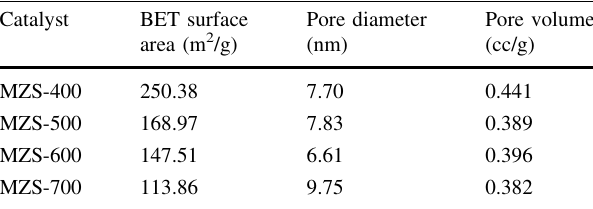
Table 1 Physical properties of zirconia prepared with various cal- cination temperatures Catalyst